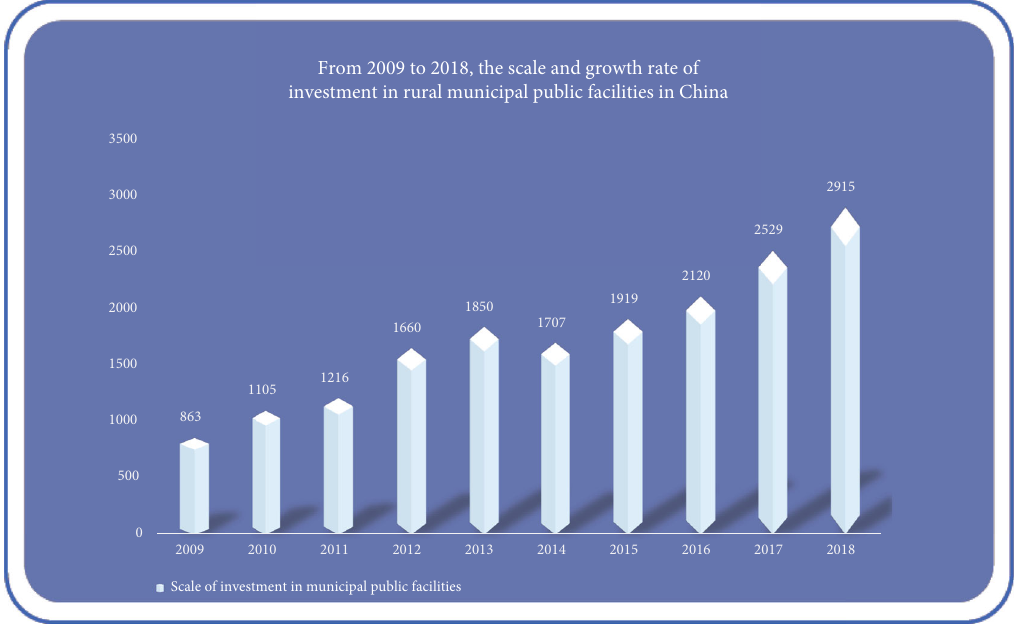
Figure 6: The scale and growth rate of investment in rural municipal public facilities in China from 2009 to